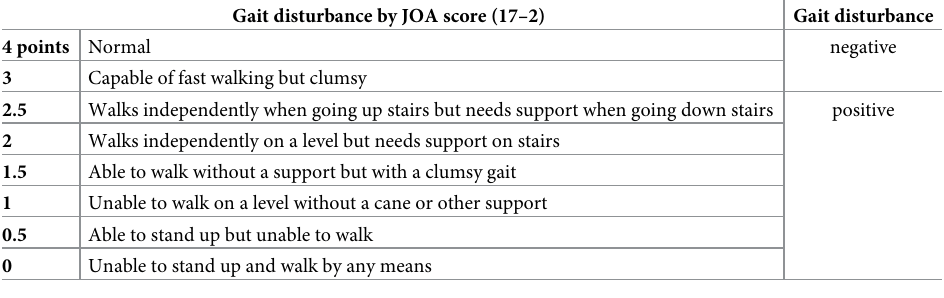
Table 3. Assessment of gait disturbance.